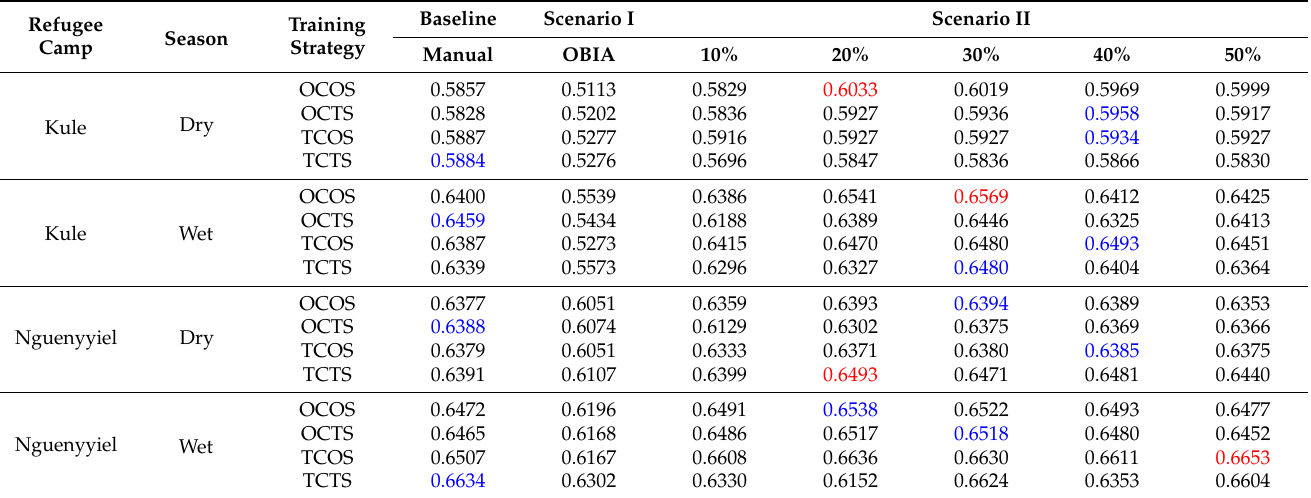
Table 2. The IoU values of built-up structures of all implemented experiments (OCOS: One Camp One Season; OCTS: One Camp Two Seasons; TCOS: Two Camps One Season; TCTS: Two Camps Two Seasons). The mean IoU values can be found in Table A2 in Appendix